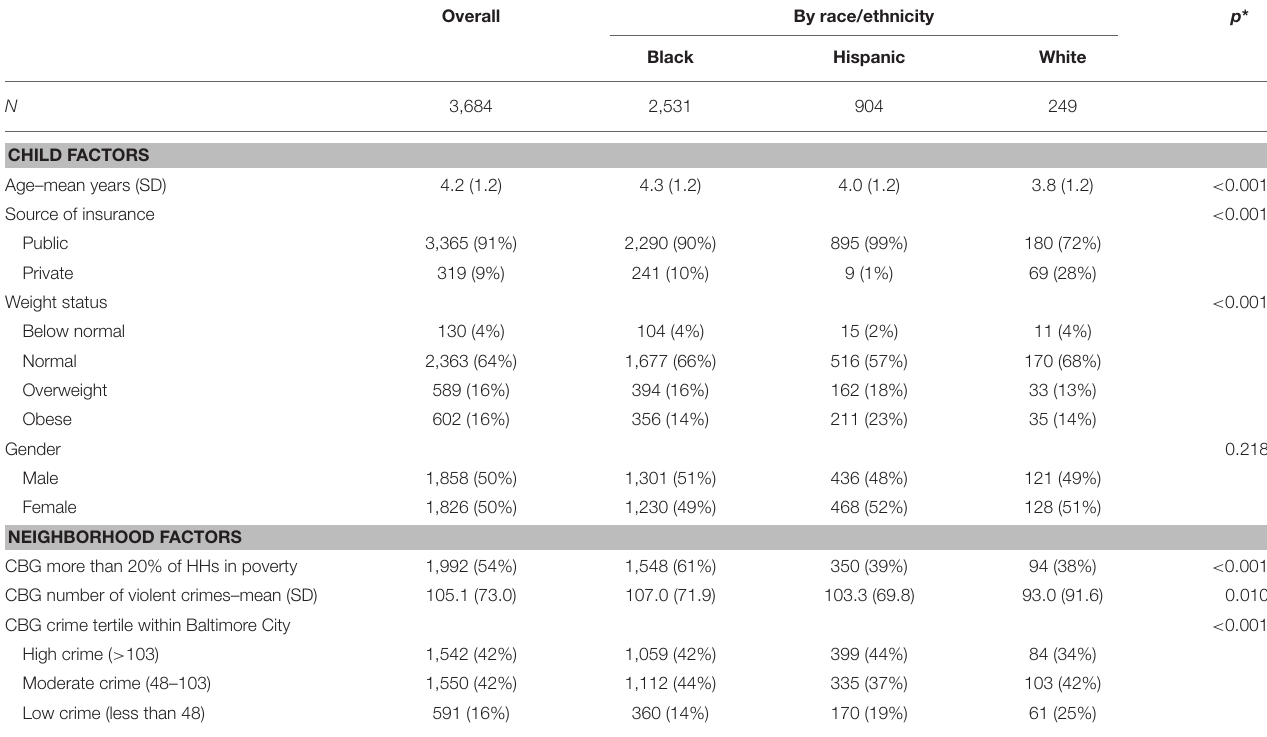
TABLE 1 | Individual and neighborhood characteristics overall and by race/ethnicity among a primary care-based clinic sample of preschoolers, October 1, 2017–November 6, 2012, Baltimore City, Maryland. Overall By race/ethnicity